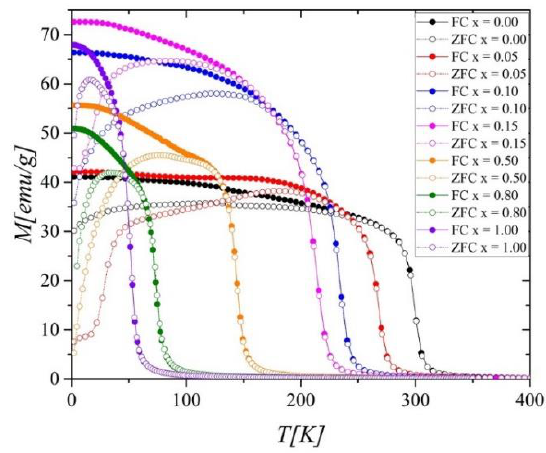
Figure 2. Magnetization M versus temperature, measured in FC and ZFC mode ( M FC and M ZFC ) at a magnetic field of 0.1 T.